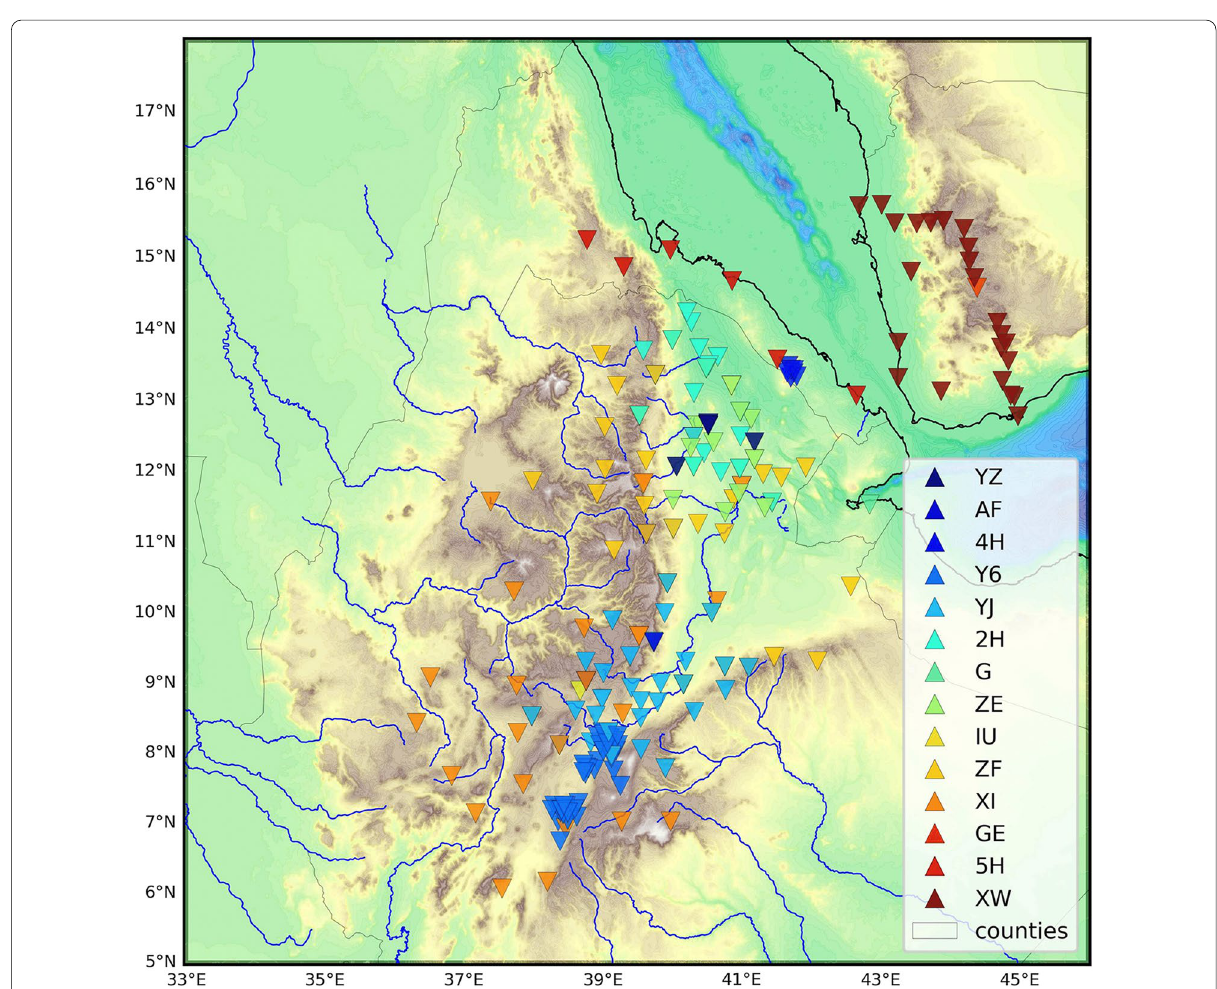
Fig. 2 Locations of the 227 seismic stations deployed in Afar region. The color code indicates the networks to which the stations